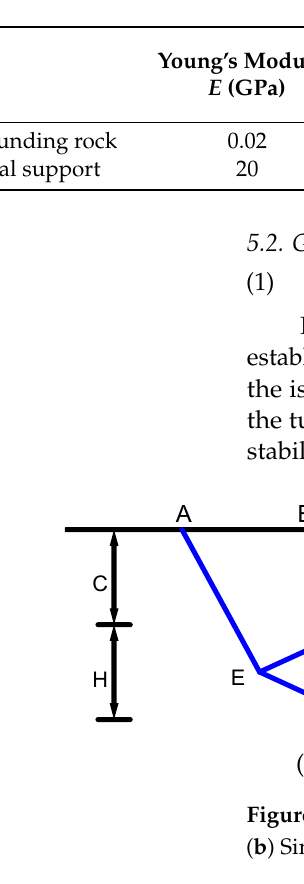
Figure 11. Numerical analysis of model. Table 7. Parameters of surrounding rock and initial support.